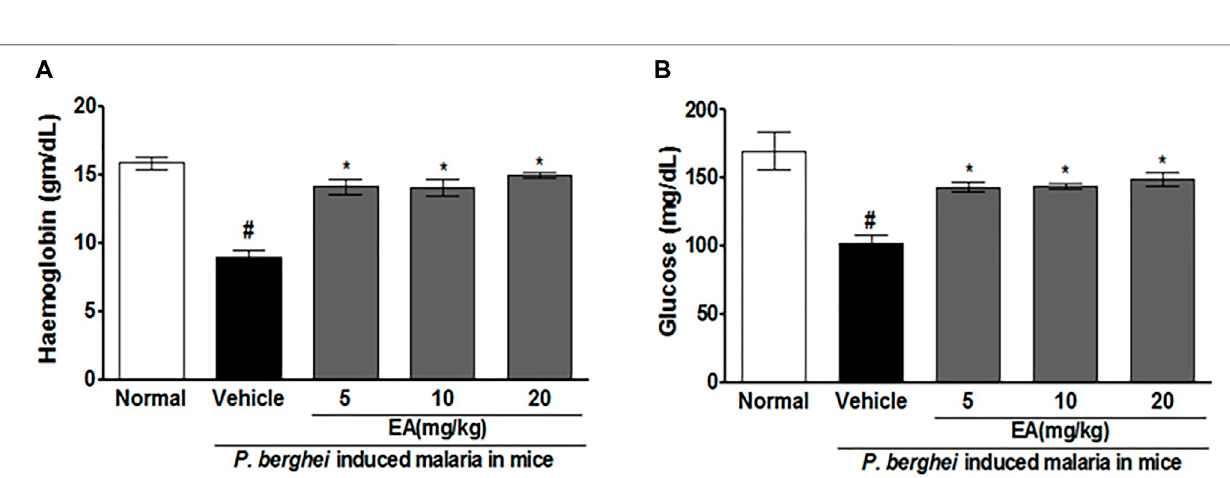
Frontiers in Pharmacology |